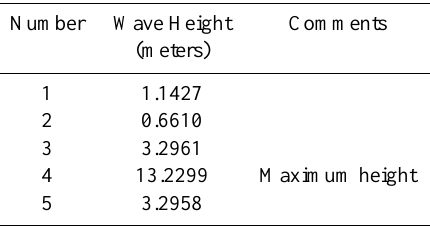
Table 1. Free wave surface close to the maximum wave. A group of 3 waves is noticeable.